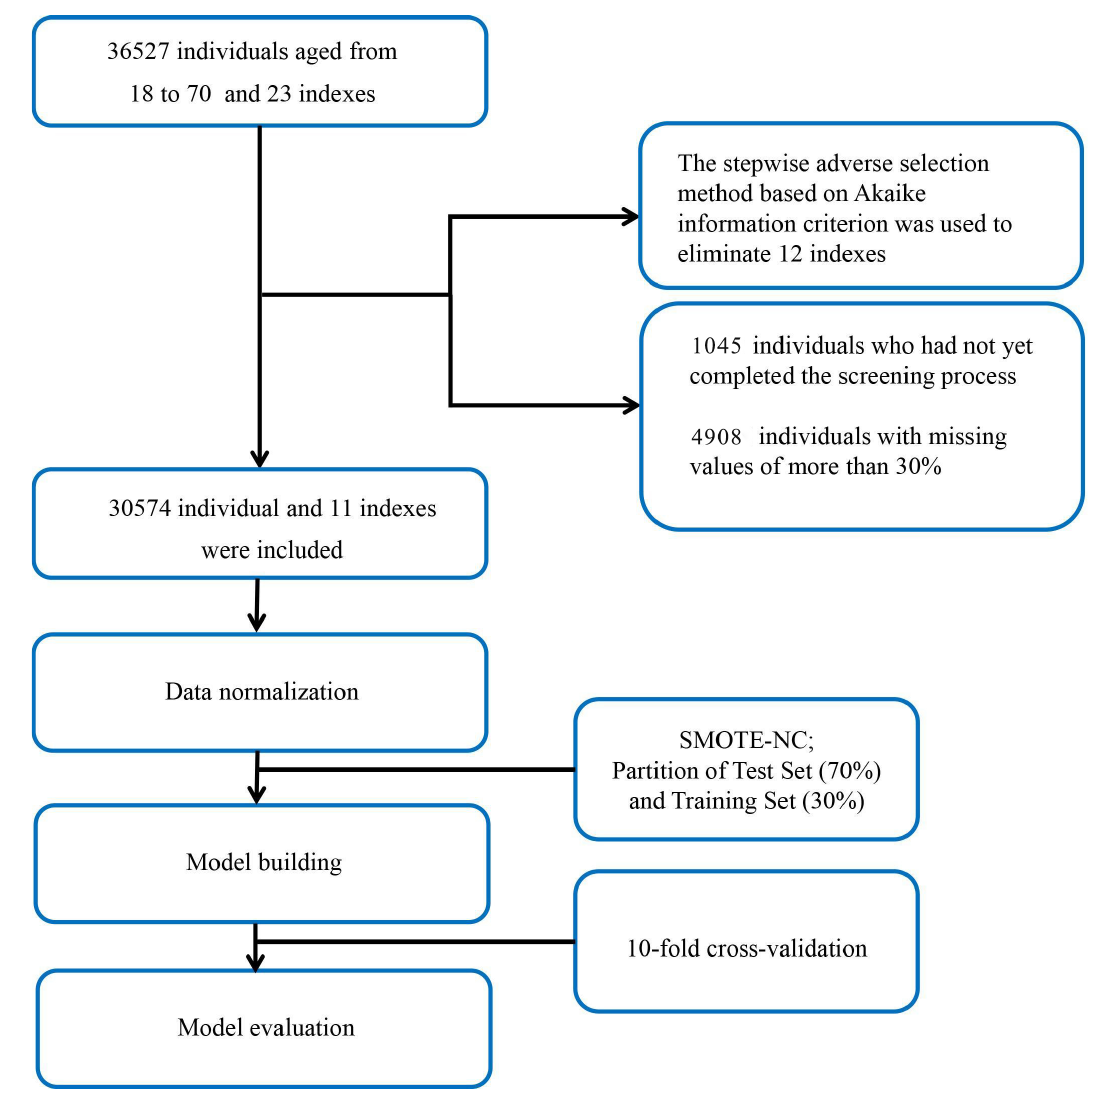
Figure 1. Data processing flowchart.